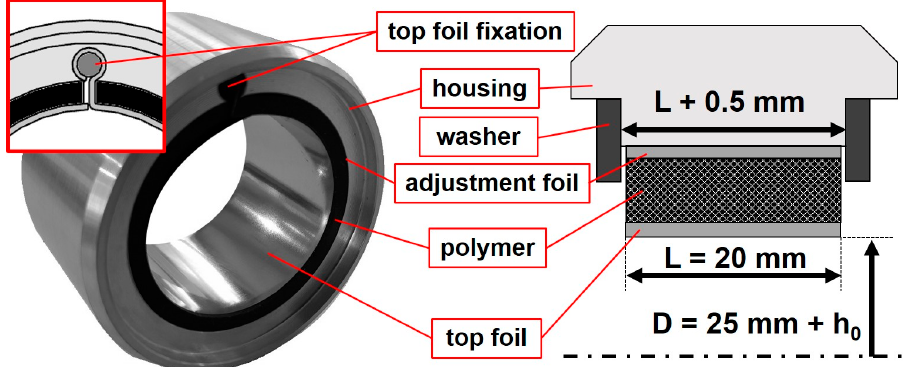
Figure 1. Assembly of the gas polymer bearing with adjustment foils; left: test bearing, right: schematic cross section of the GPB.